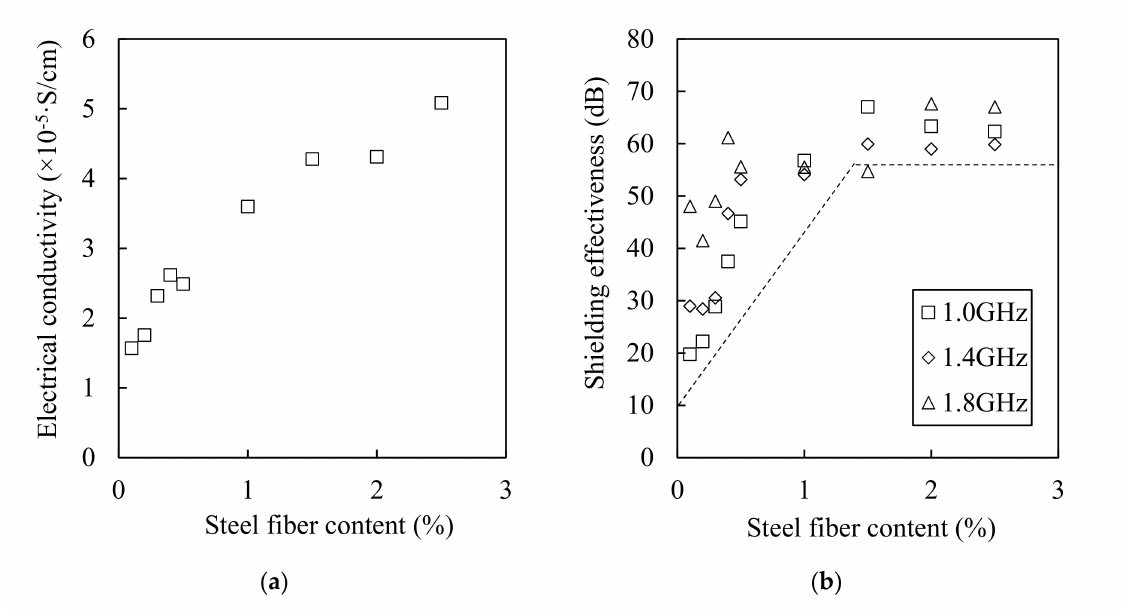
Figure 15. Relationships between electrical conductivity ( a ) and shielding e ff ectiveness ( b ) as a function of steel fiber content.